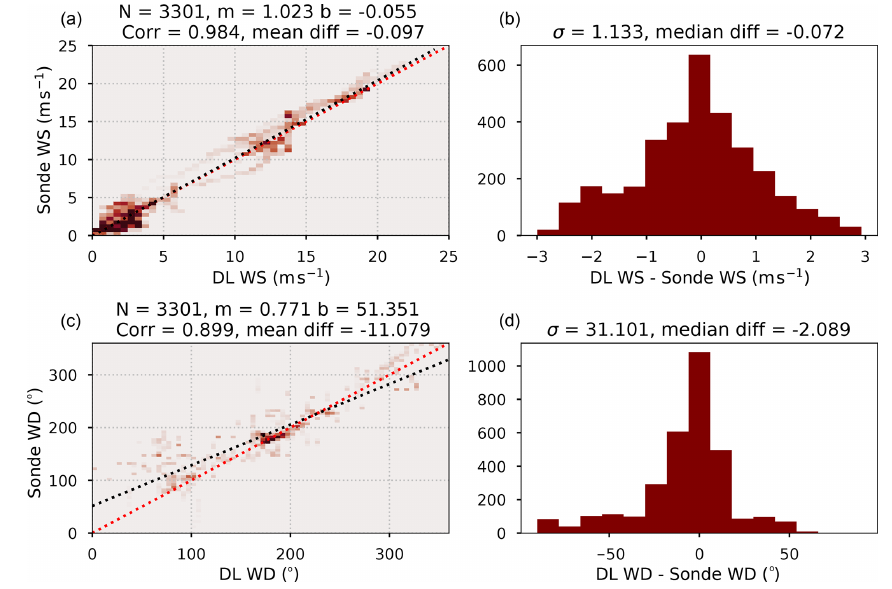
Figure 9. Similar to Fig. 4 but comparing kinematic measurements from the radiosondes and the AERI.